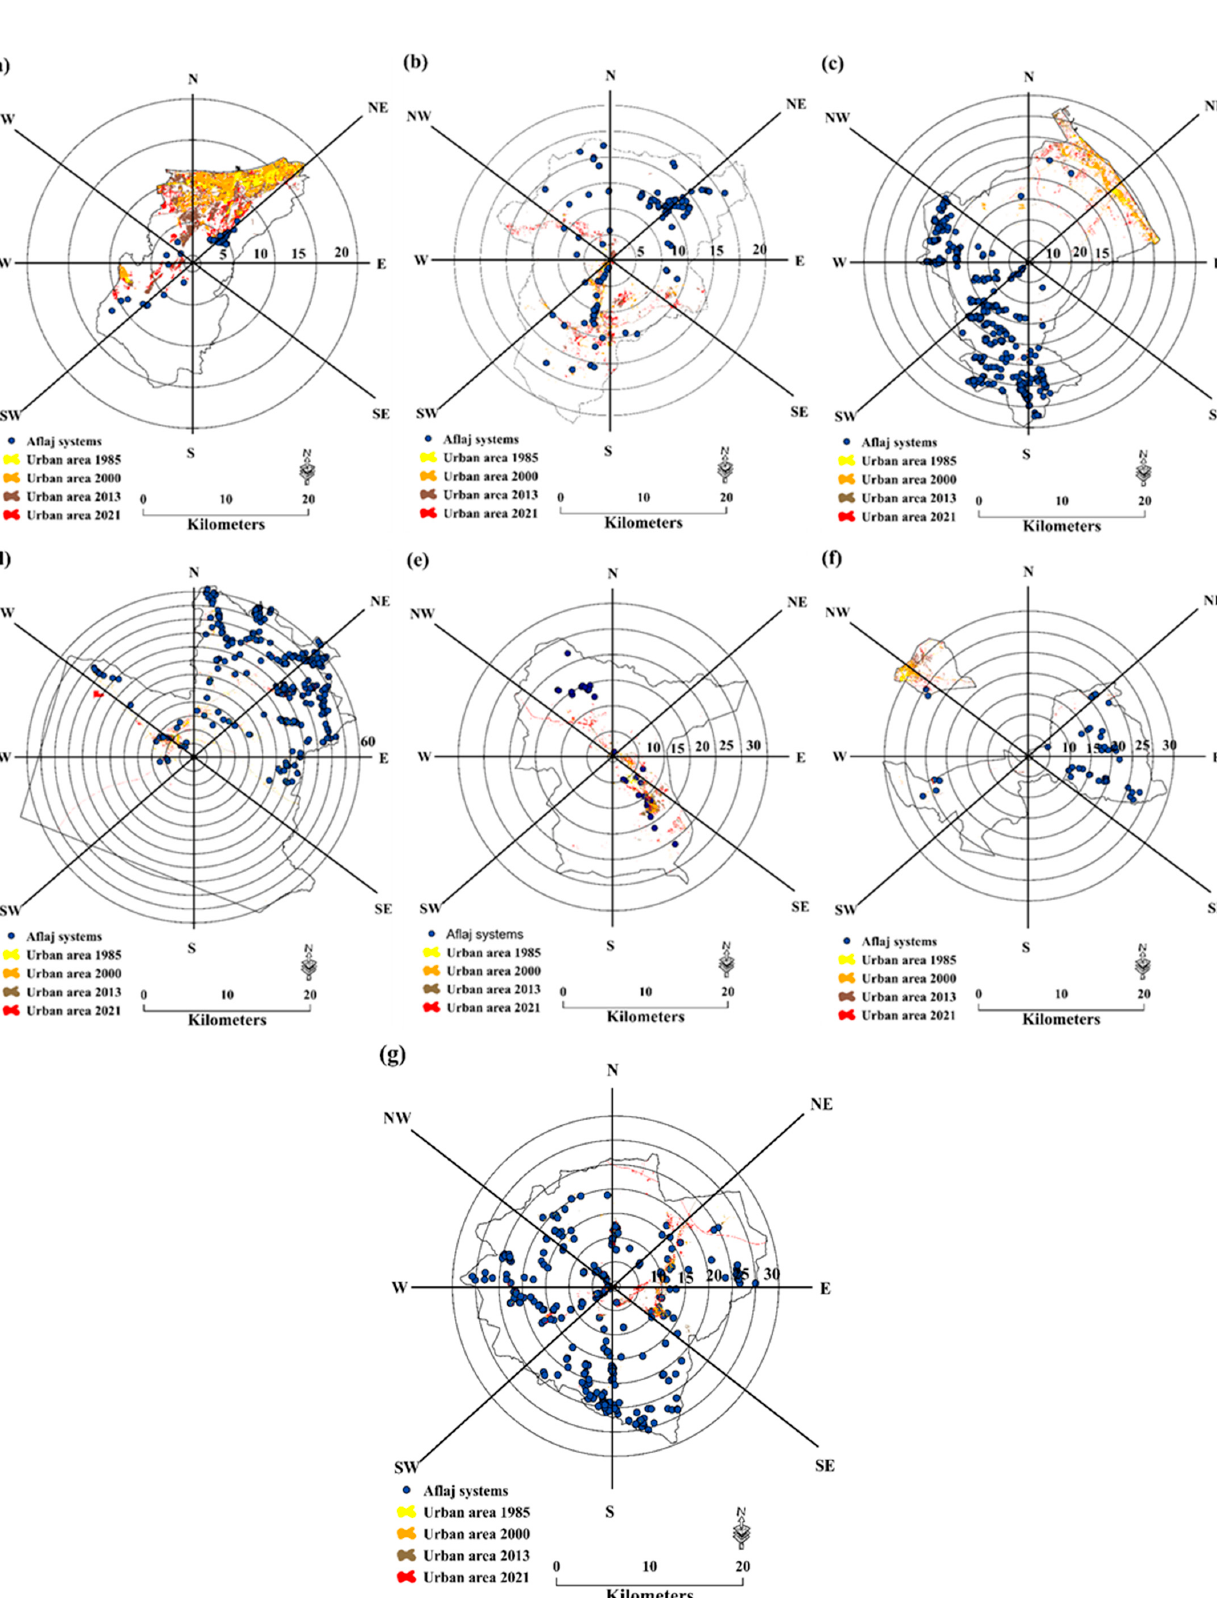
Figure 11. Directions of urban expansion between 1985–2021 in ( a ) Bawsher, ( b ) Nizwa, ( c )